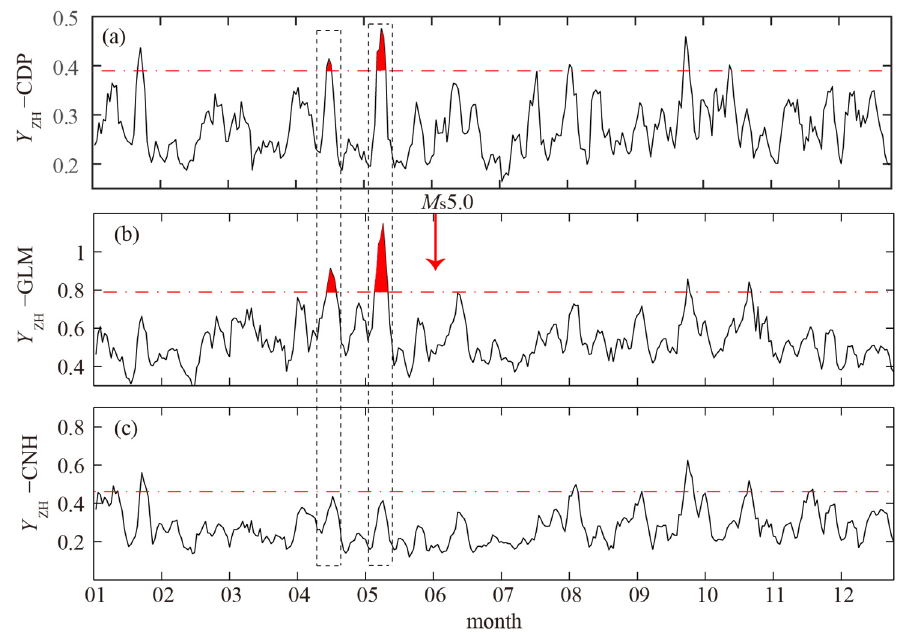
Figure 4. Polarization ratios of Y ZH at ( a ) CDP, ( b ) GLM, and ( c ) CNH stations at approximately 0.1 Hz during